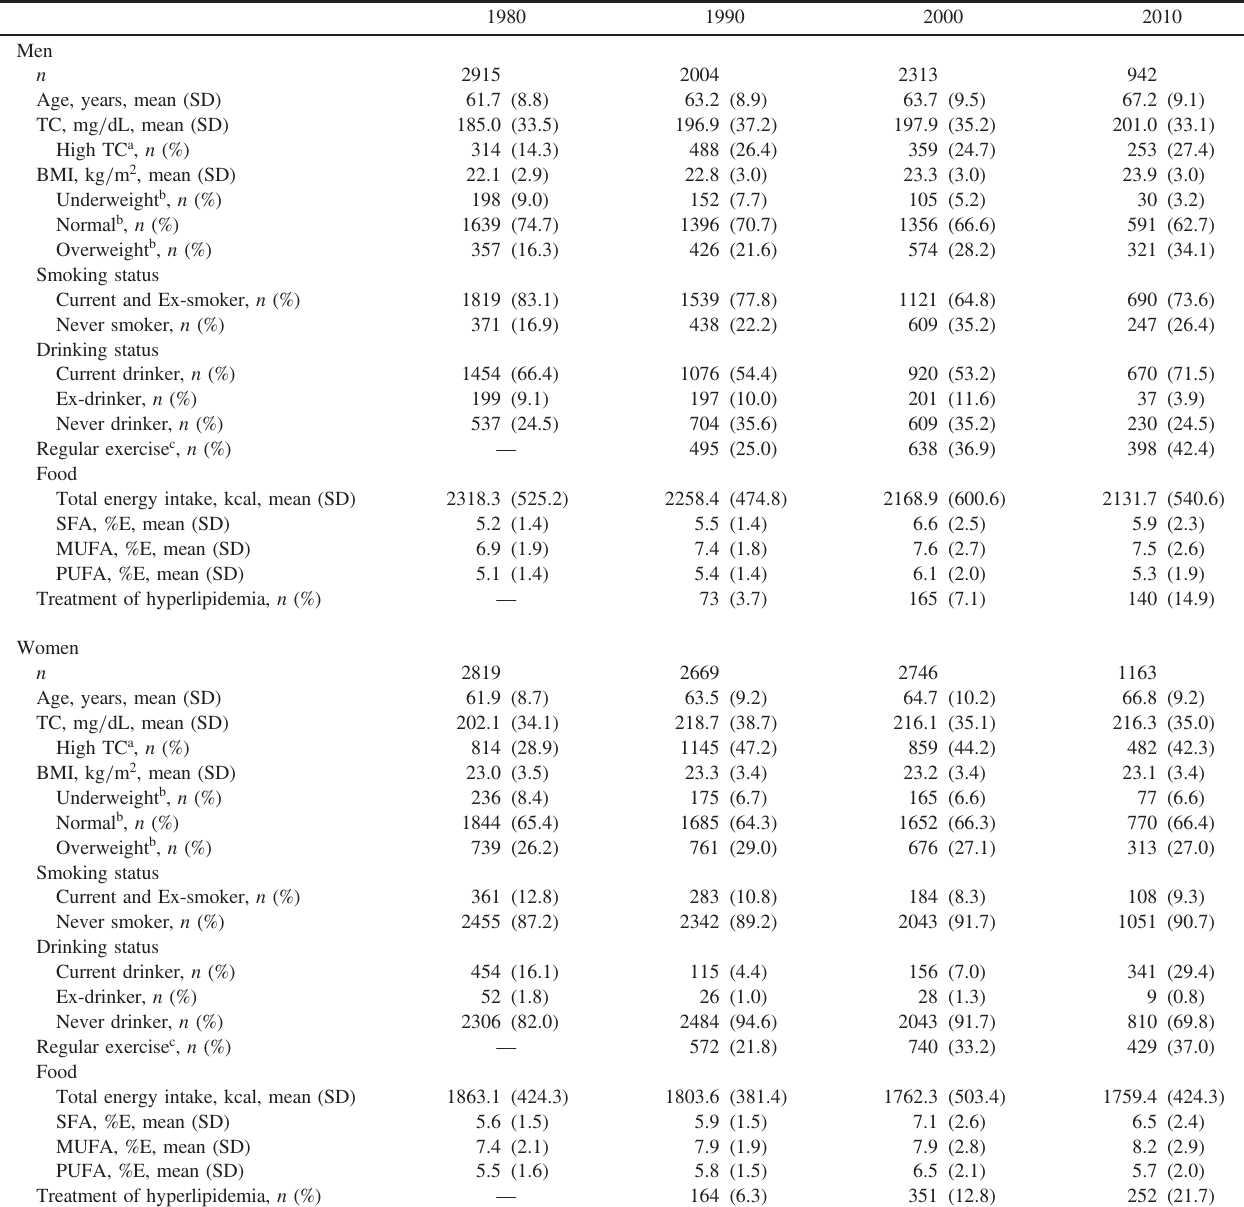
Table 1. Characteristics of subjects aged 50 years and above in the study